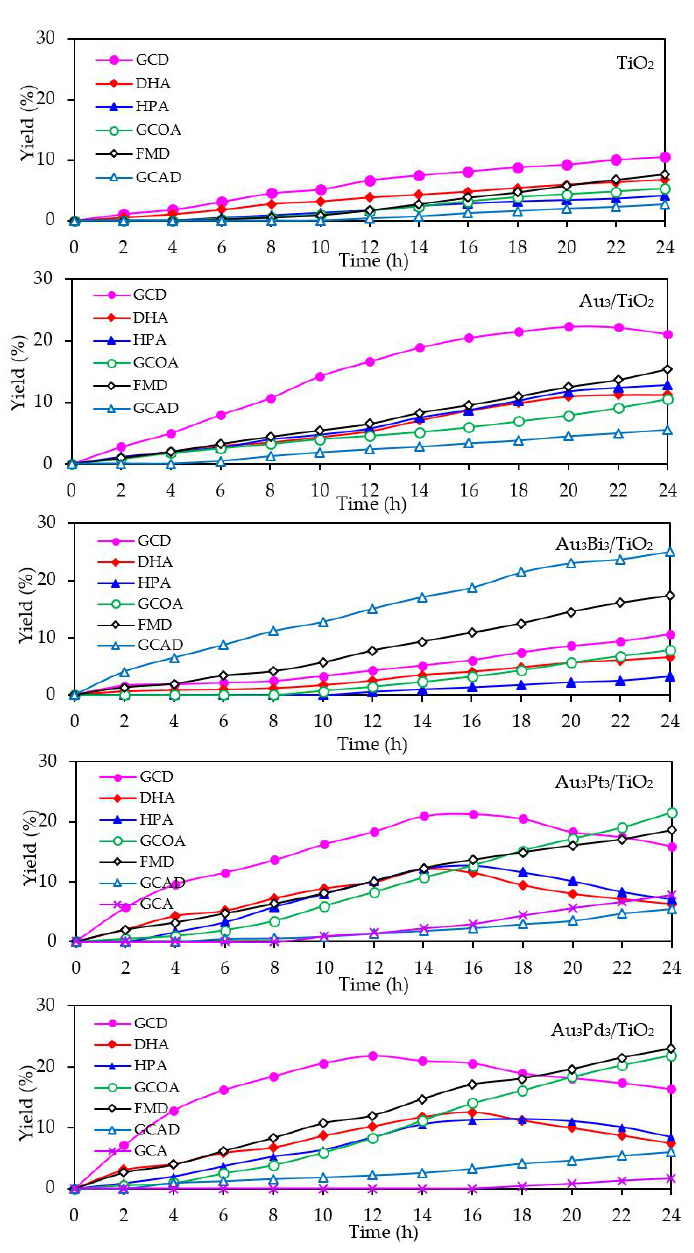
Figure 15. Yield of selected products obtained from the glycerol photocatalytic conversion via the TiO 2 , Au 3 /TiO 2 and respective Au 3 M 3 /TiO 2 photocatalysts at a loading of 3.0 g/L, light intensity of 4.7 mW/cm 2 , and using O 2 as the electron acceptor.